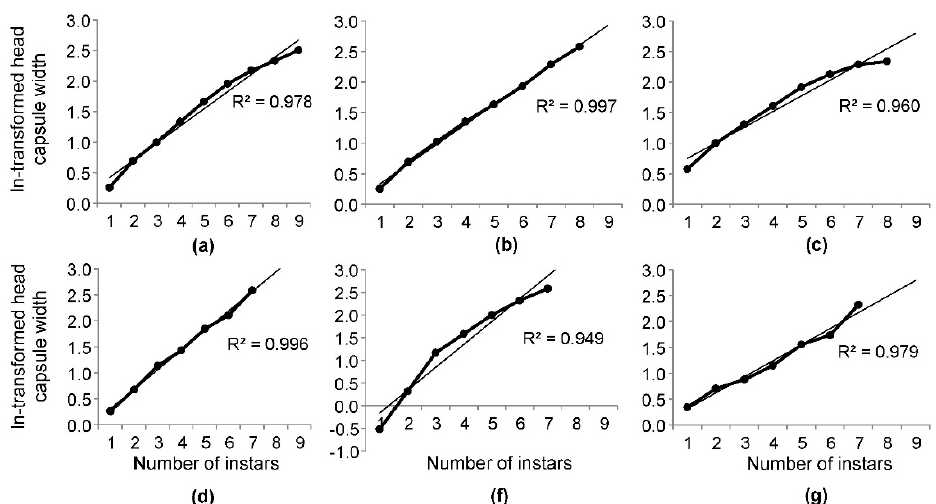
Figure 6. Observed changes of the ln-transformed head capsule widths of Dendrolimus pini larvae with their growth presented by increasing instar (bold solid line), fitted lines, and coefficients of determination indicating the goodness of fit based on ( a ) the visual approach and NLLS; ( b ) the kernel density estimation (KDE) approach and NLLS; ( c ) the clustering approach; ( d ) the data presented by Il’inskij and Tropin [13]; ( f ) the data presented by ´Sliwa [11]; and ( g ) the data presented by Pszczolkowski and Smagghe